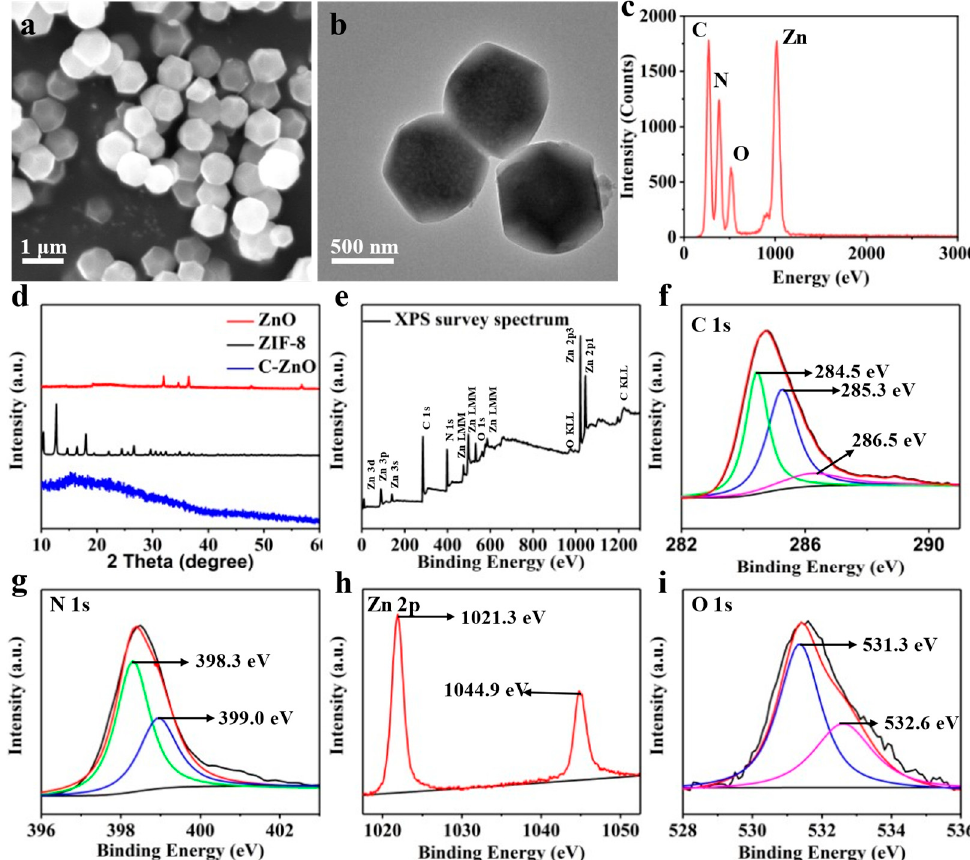
Figure 2. ( a ) SEM image, ( b ) TEM image, and ( c ) corresponding EDS spectrum. ( d ) XRD patterns. ( e ) XPS spectrum and corresponding high-resolution XPS spectra of ( f ) C 1s, ( g ) N 1s, ( h ) Zn 2p, and ( i ) O 1s.